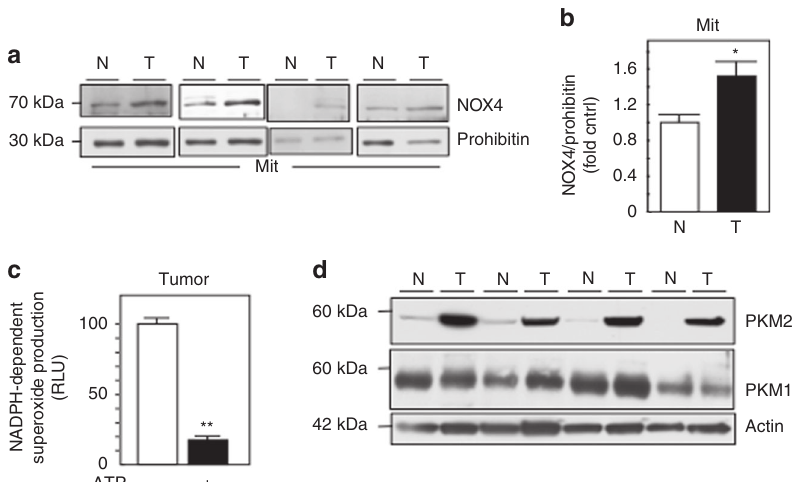
Fig. 8 Characterization of NOX4 and PKM2 in human RCC tumors and adjacent tissue. a Mitochondrial fractions were prepared from human tumors (T) or uninvolved adjacent tissue (N). NOX4 expression was examined by western blot analysis. Prohibitin was probed as a mitochondrial marker and loading control. b Quantitation of NOX4 distribution in the mitochondrial fraction from a . The results are expressed as the means using one-way ANOVA with Tukey ’ s post hoc test where ± S.E.M. * p < 0.05 compared to normal (N). c Mitochondria fractions were prepared from RCC tumors and NADPH- dependent superoxide generation was examined in the presence (+) or absence ( − ) of ATP. The results are from eight tumors and are expressed as the means using one-way ANOVA with Tukey ’ s post hoc test where ± S.E.M. ** p < 0.01 is compared to without ( − ) ATP. d PKM2 and PKM1 expression